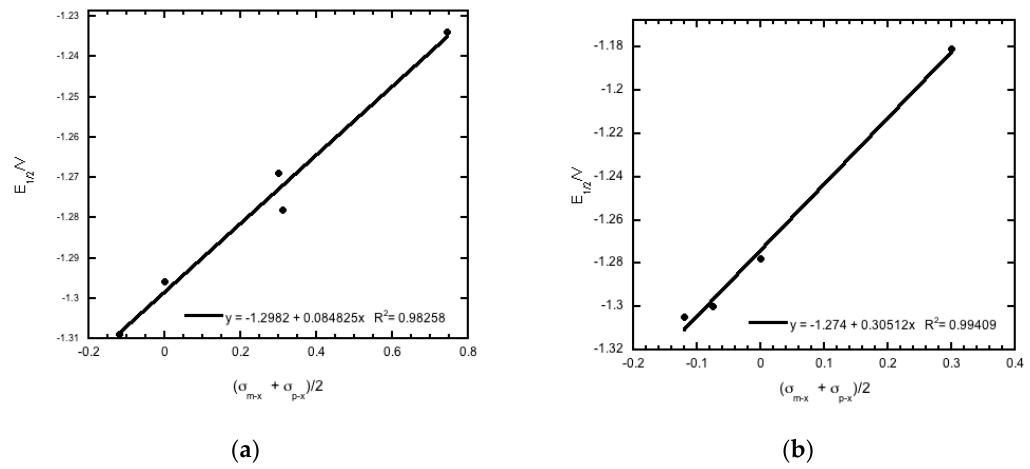
Figure 4. Plot of ( a ) ( σ m − x + σ p − x )/2 for substituent group R 2 versus half-wave potential (E 1/2 vs. Fc/Fc + ) for compounds 1a – 1e , and ( b ) ( σ m − x + σ p − x )/2 for substituent group R 1 versus half-wave potential (E 1/2 vs. Fc/Fc + ) for compounds 1d , 2d , 3d , and 4d . Hammett substituent constant values are taken from reference [29].